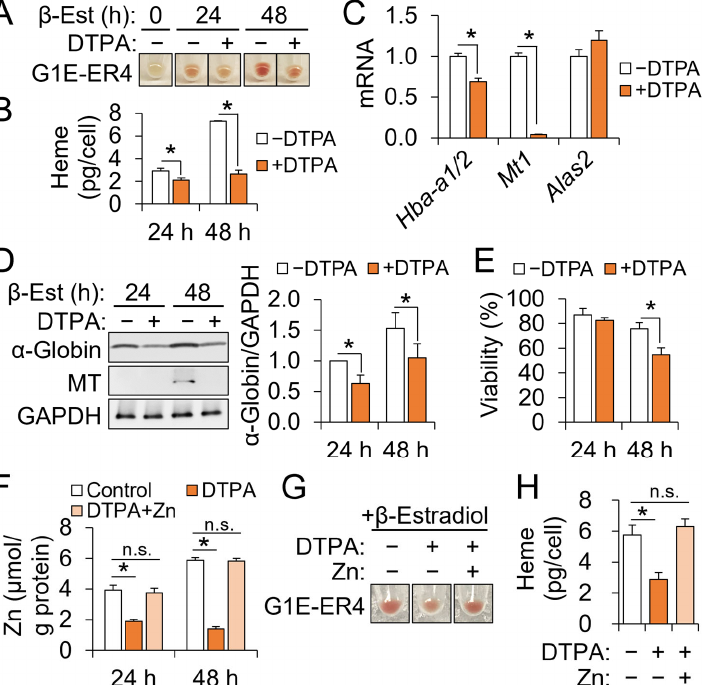
Figure 2. Mild cellular zinc restriction impairs heme biosynthesis by erythroid progenitor without compromised cell viability. ( A ) Representative cell pellet images of G1E-ER4 cells differentiating under zinc restriction by DTPA. ( B ) Decreased heme contents by DTPA in developing G1E-ER4 cells ( n = 3). ( C ) Effects of DTPA on Mt1 , Hba-a1/2 , and Alas2 transcripts at 24 h of differentiation, normalized to Tbp ( n = 3). ( D ) Responses of α -globin and metallothionein protein abundance to zinc restriction in differentiating G1E-ER4 cells ( n = 4). ( E ) Viability of G1E-ER4 cells with or without DTPA treatment for 24 and 48 h ( n = 3). ( F – H ) Restoration of cellular zinc levels ( F ), hemoglobinization ( G ), and heme contents ( H ) of DTPA-treated G1E-ER4 cells by equimolar zinc (50 µ M) treatment ( n = 4). Cells were treated with β -estradiol ( β -Est) for differentiation and DTPA or zinc for each zinc condition at 0 h, and cultured for 24 or 48 h. Cell pellet images and heme data were collected 48 h after zinc treatments and differentiation ( n = 4). Data presented as mean ± SD. * p < 0.05. β -Est, β -estradiol; DTPA, diethylenetriaminepentaacetic acid; n.s., not